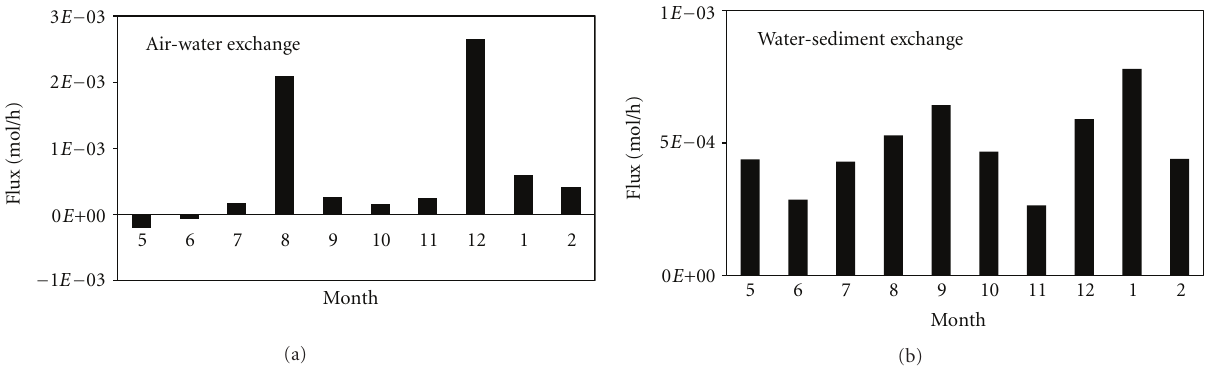
Figure 5: α -HCH fluxes over the air-water interface (a) and the water-sediment interface (b). The positive values indicate net inputs from air to water or from water to